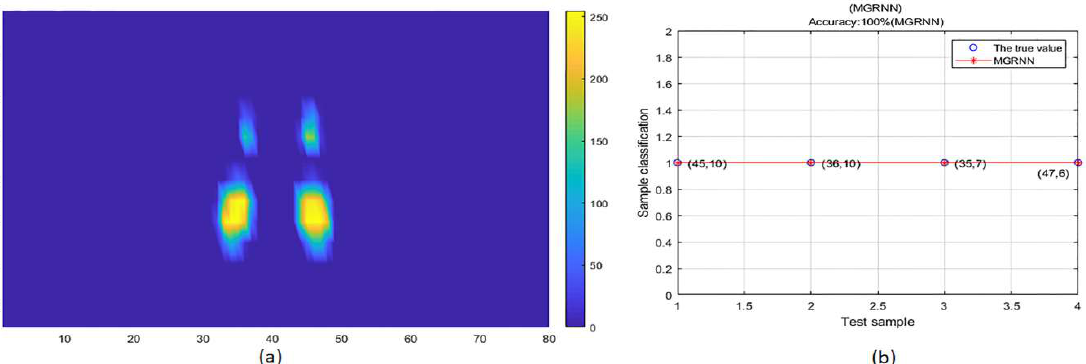
Figure 20. Three interference sources with same frequencies at 6 GHz. ( a ) original image; ( b ) result of classification.